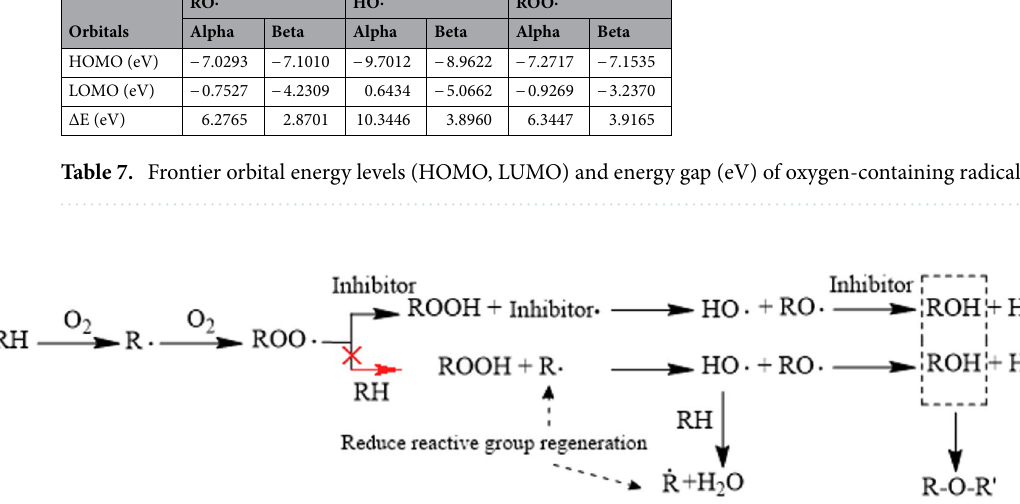
Figure 9. Reaction mechanism of antioxidants to eliminate oxygen-containing radicals during coal